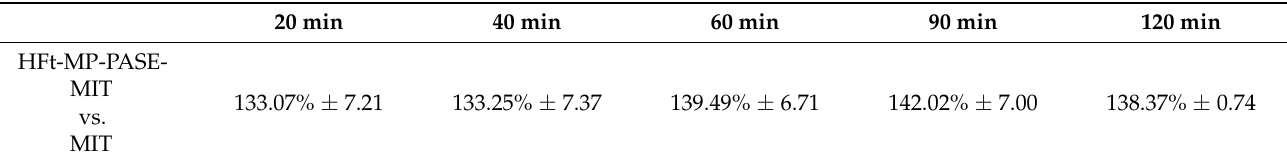
Table 2. Percentage of the differential cellular uptake of 0.5 µ M HFt-MP-PASE-MIT versus MIT at 37 ◦ C detected by flow cytometry at different time points.